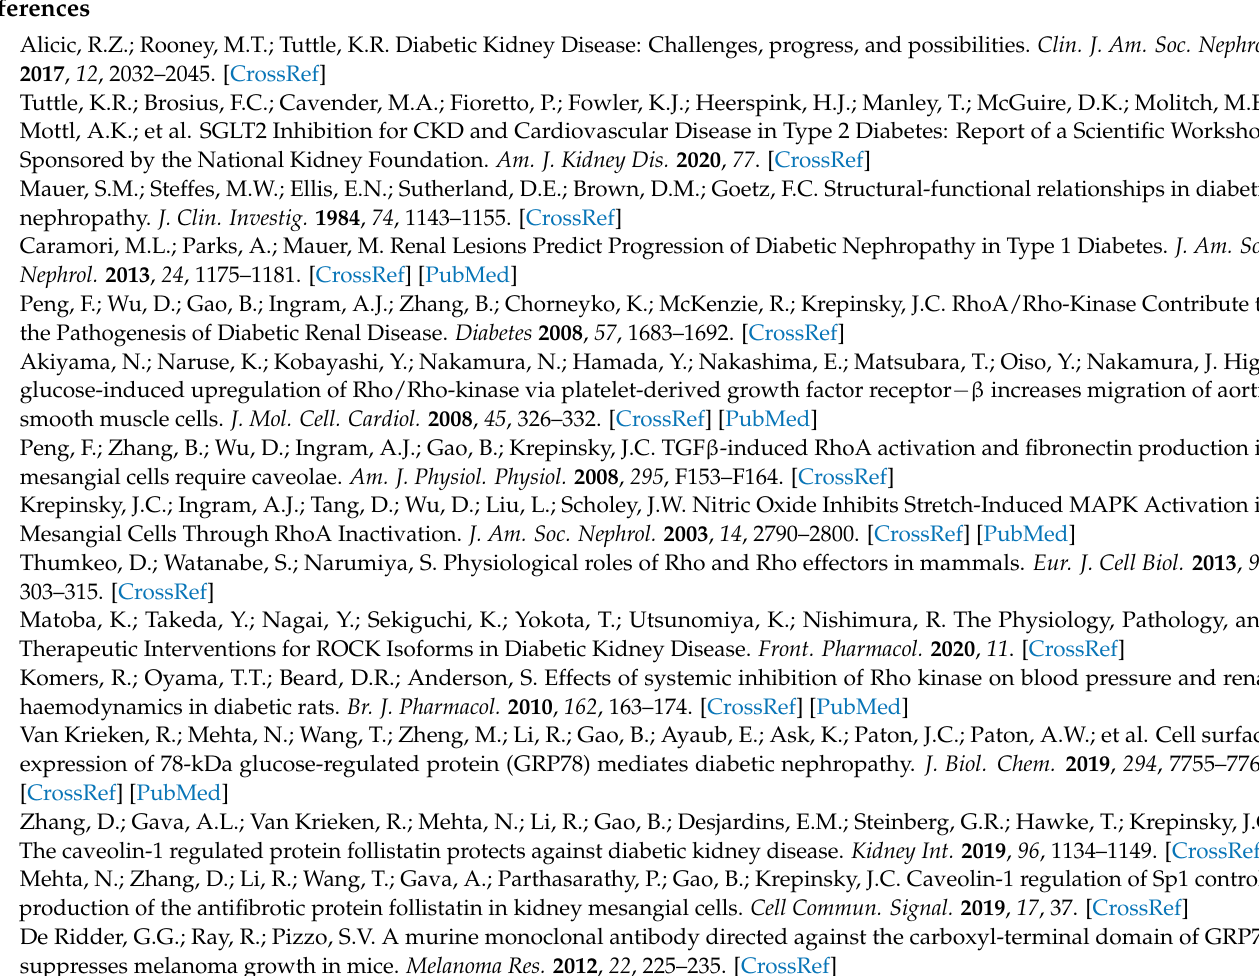
Figure A1. Cell surface GRP78 inhibition does not attenuate ER stress. Transcript levels for the ER stress response genes IRE1 α ( A ) and CHOP ( B ) were assessed by qPCR. The increase seen in diabetic mice was not attenuated by treatment with C38 ( n = 4, * p < 0.05, ** p < 0.01).